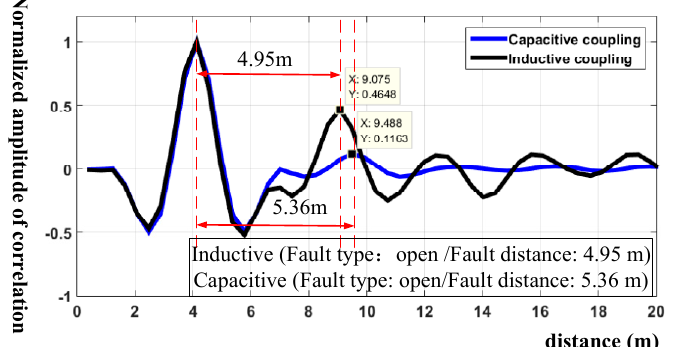
Figure 8. Simulation of cable fault diagnosis with an open circuit at 4.75 m.